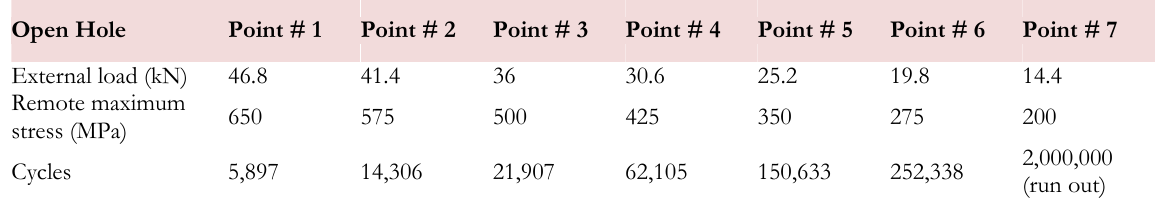
Table 1: Stress results for the OH